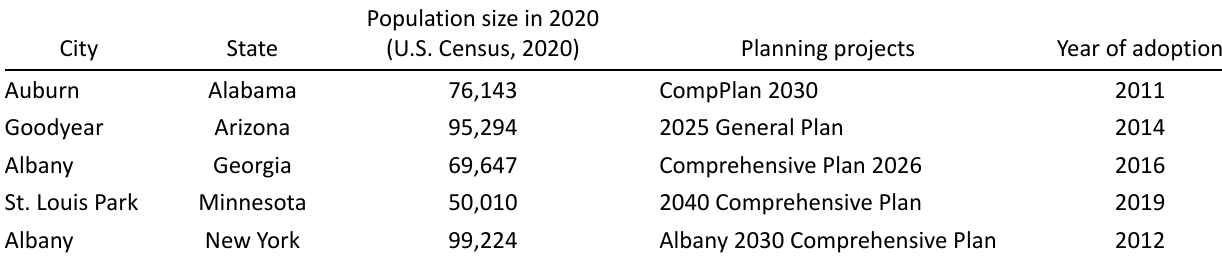
Table 1. Study cities and the reviewed planning projects.